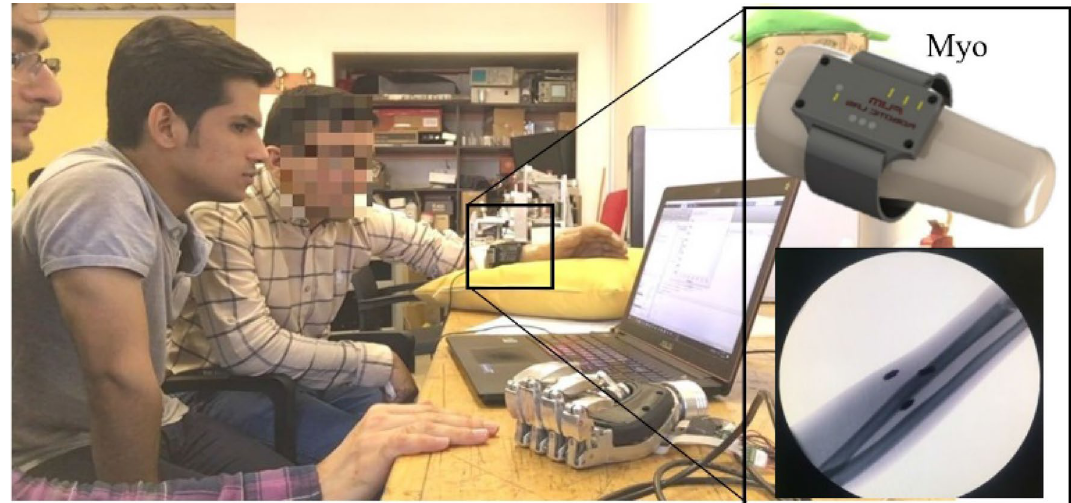
Figure 3. Connection of the prosthesis to the Myo along with an x-ray that shows the placement of magnets inside the patient’s amputated arm. The measured magnetic fields by the Myo sensors are immediately transferred to a computer. Processing the measured signals is carried out by MATLAB software to map the magnetic field to the bionic hand movement. These movements are then fed to the present bionic hand motors for the appropriate gesture. In this picture, the patient has voluntarily closed his prosthesis hand. The participants gave written consent to include their images in this article.